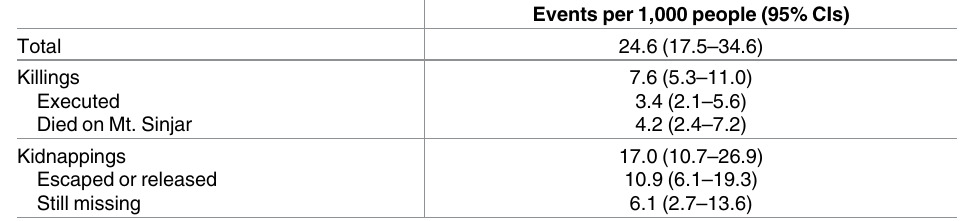
Table 4. Estimated probabilities of killings and kidnappings of Yazidis from